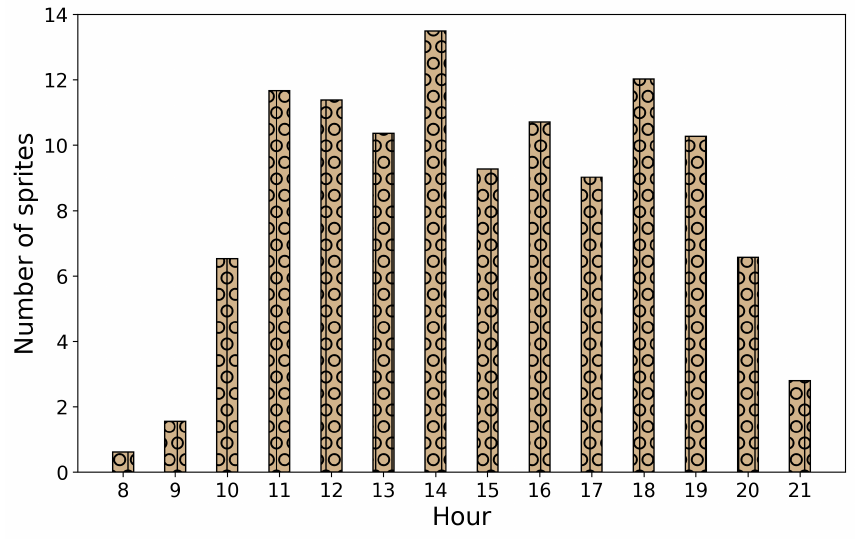
Figure 12. Estimated hourly number of sprites in case B (see caption of Table 1 for an explanation of the three different cases).